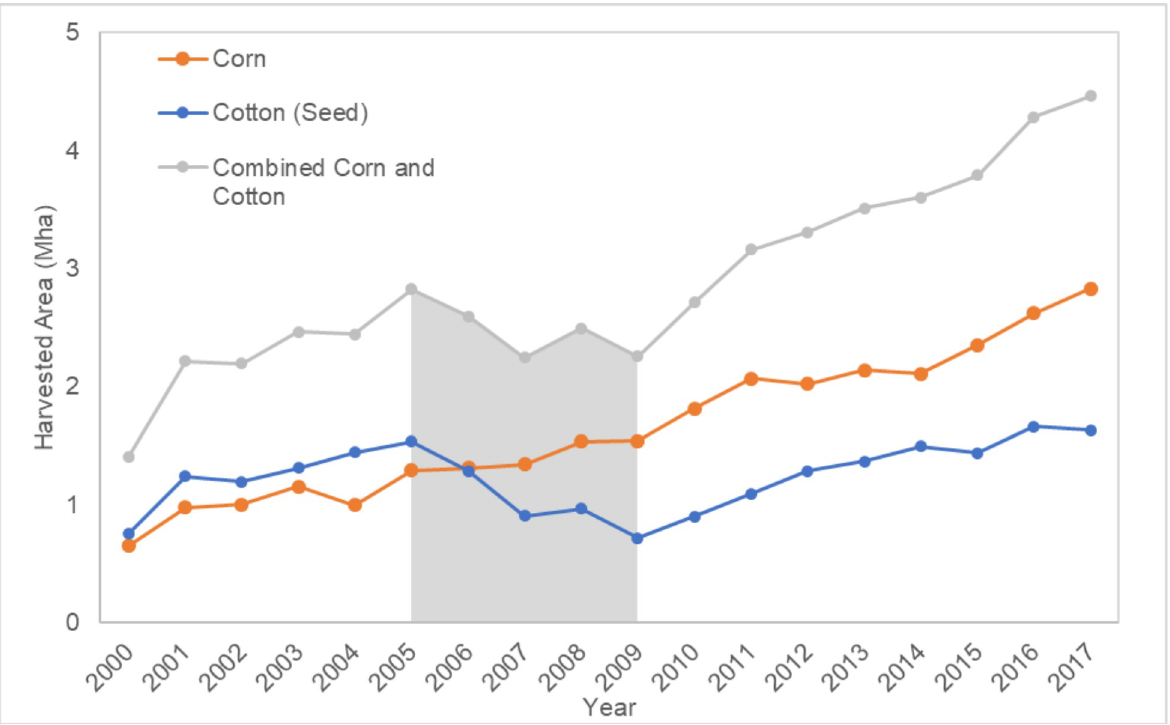
Fig 12. Total corn and cotton production in Western Africa from 2000–2017 based on FAO statistics [17]. The period 2005–2009 is highlighted in grey to emphasize the total production trend in that time period.